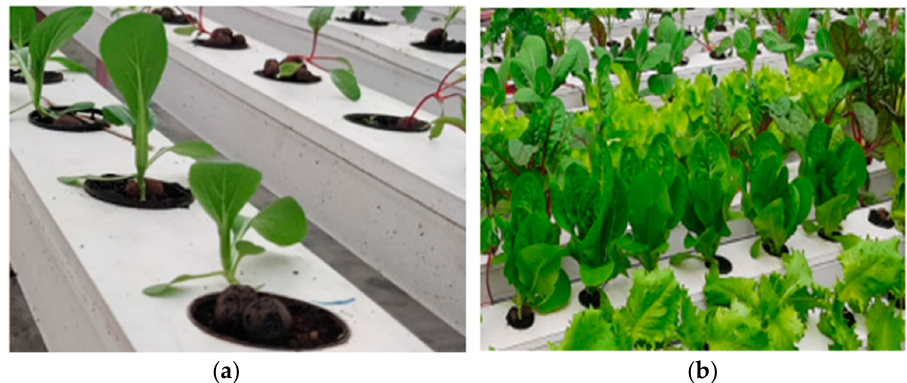
Figure 4. Stages of growth of romaine lettuce in the NFT: ( a ) saplings; ( b ) growing phase. Table 3. Parameters and their corresponding values in the NFT method of